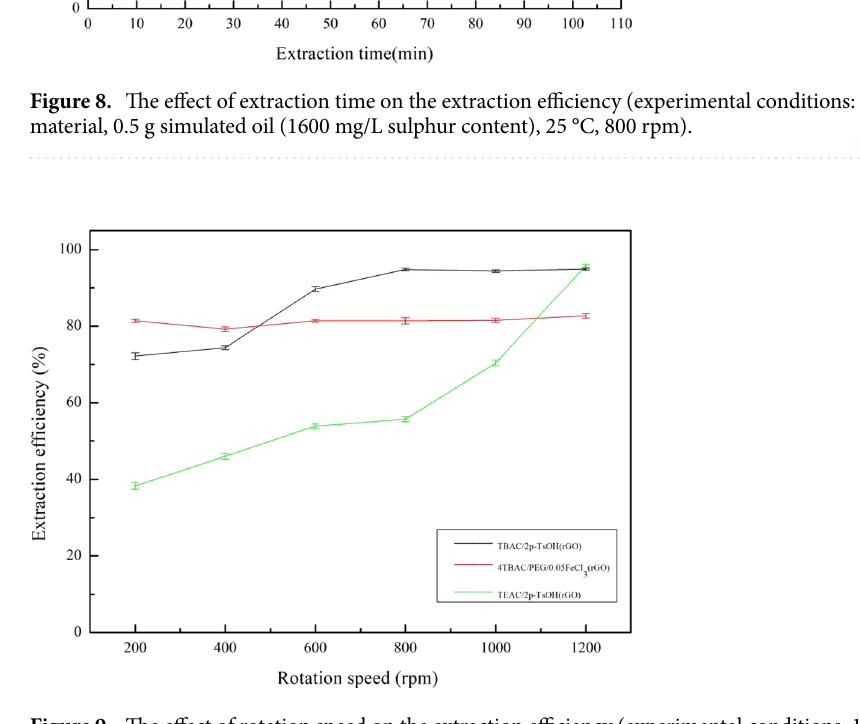
Figure 9. The effect of rotation speed on the extraction efficiency (experimental conditions: 1.2 g composite material, 0.5 g simulated oil (1600 mg/L sulphur content), 25 °C, 60